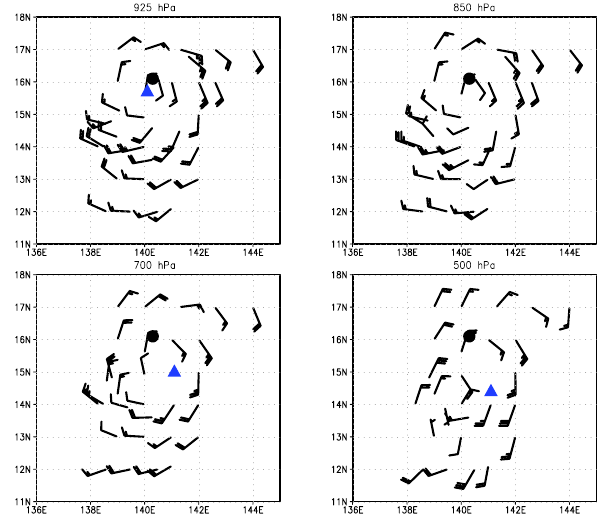
Figure 3. Dropwindsonde observations from the Nuri 2 flight (as in Fig. 2).